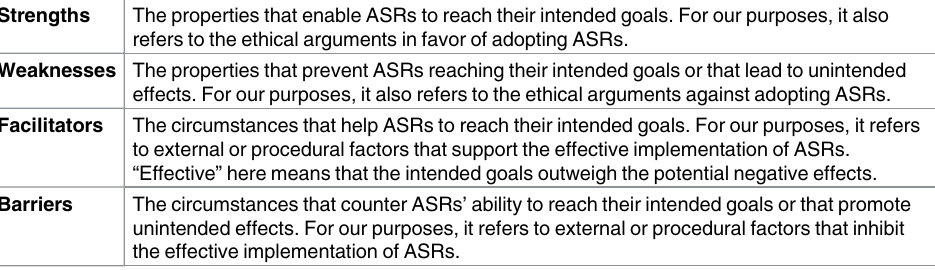
Table 1. Definitions for SWFBs of ASRs.